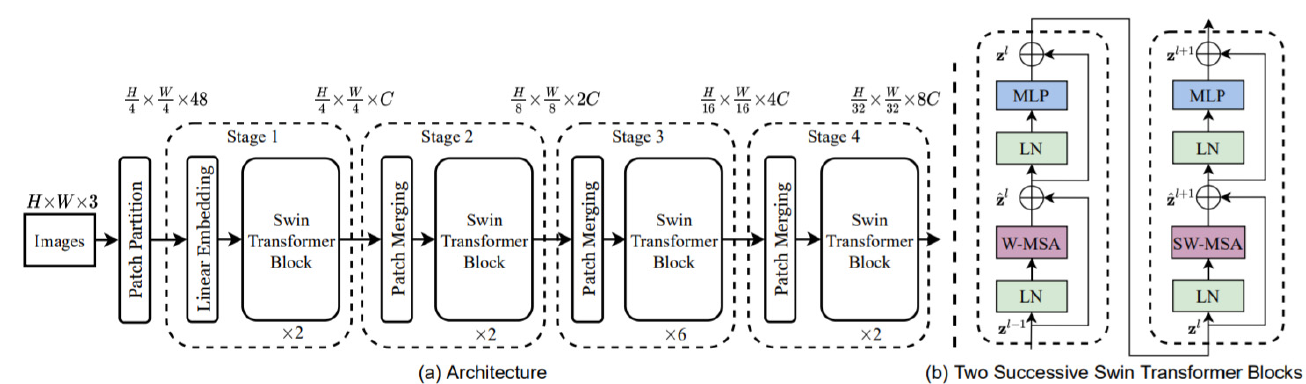
Figure 5. ( a ) The architecture of a Swin Transformer and ( b ) two successive Swin Transformer Blocks. SW-MSA and W-MSA are multi-head self-attention modules with shifted windowing and regular settings, respectively [57].